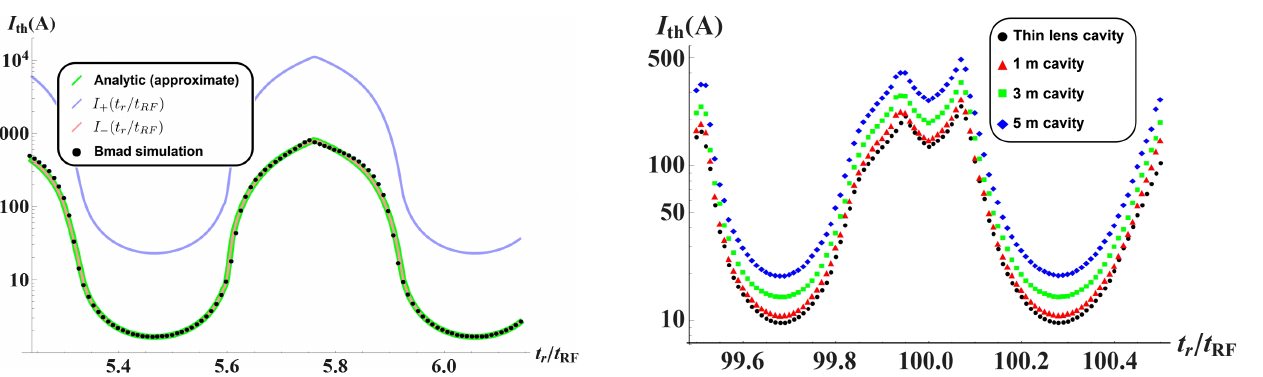
FIG. 21. Comparison of the I obtained from the BMAD FIG. 20. Comparison of the I obtained from the approximate th th simulation for case A with different cavity length. Parameters analytic formula [Eq. (19)], the two candidates [Eq. (20)], and the used are identical as in Fig. BMAD simulation for the case D3. The parameters used are identical as in the case D1, except for the optics.